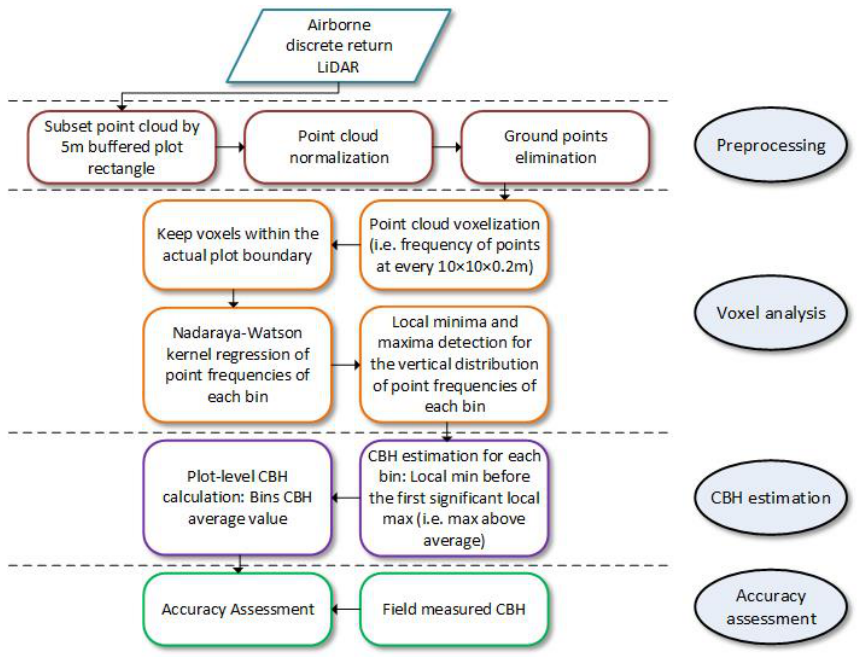
Figure 3. Schematic workflow of the voxel-based method for estimating canopy base height (CBH).